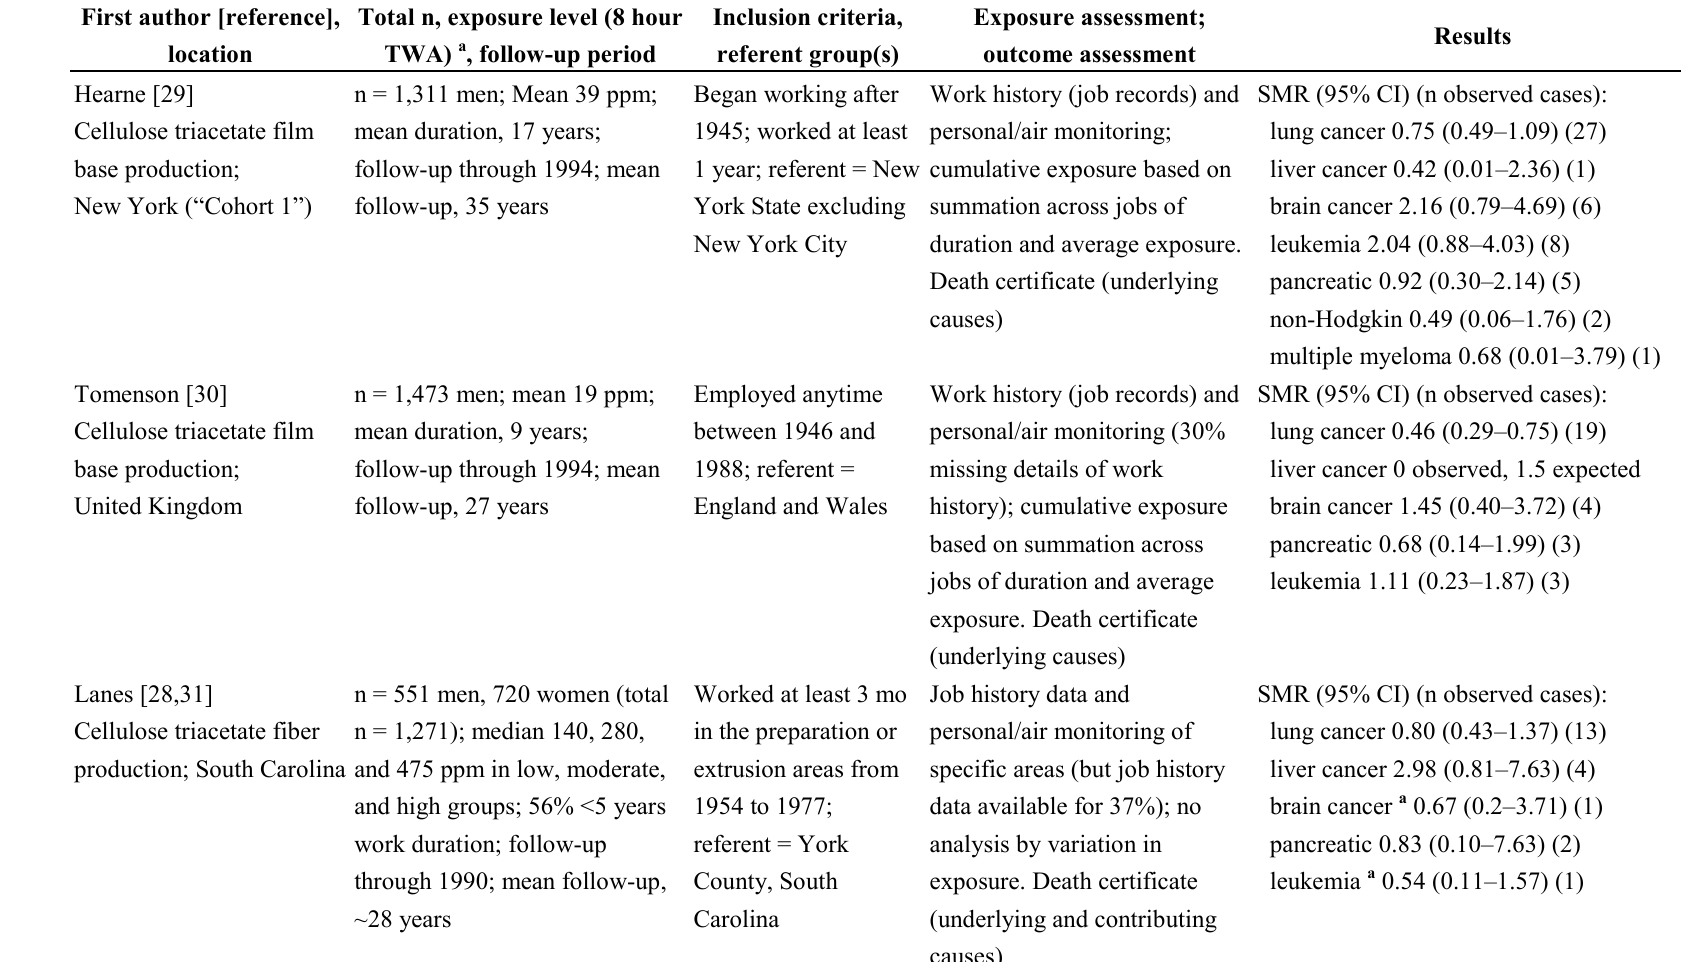
Table 1. Summary of cohort studies of cancer risk and dichloromethane